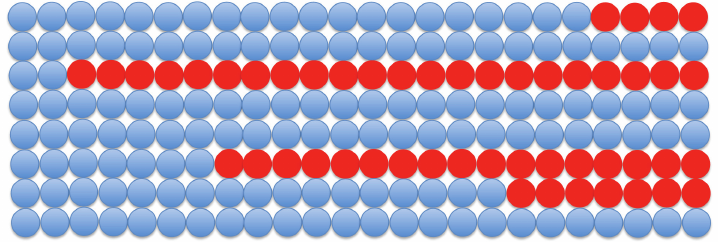
Figure 4. The conceptual model for mutant number calculations, the case of neutral mutants in a colony growing along the surface of a cylinder (2D flat front). Red circles denote mutants and blue circles wild-type cells.